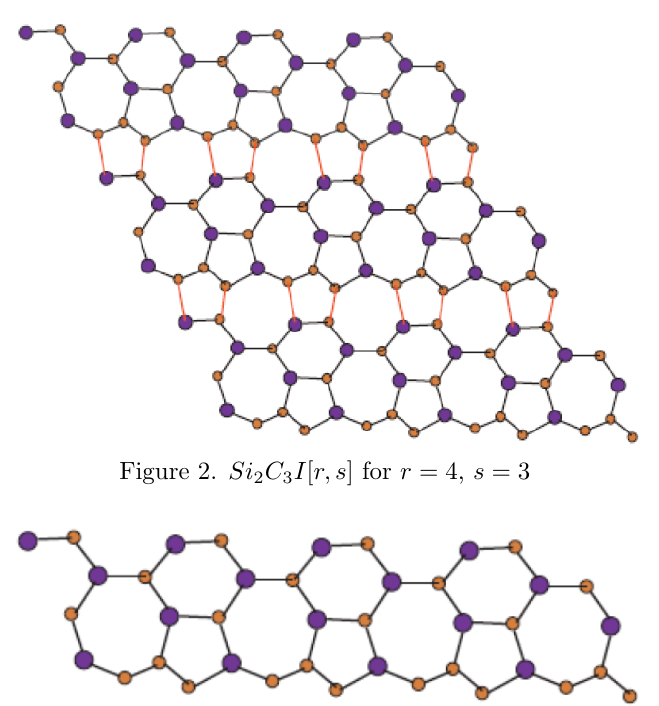
Figure 3. Si 2 C 3 I [ r, s ] for r = 4, s =